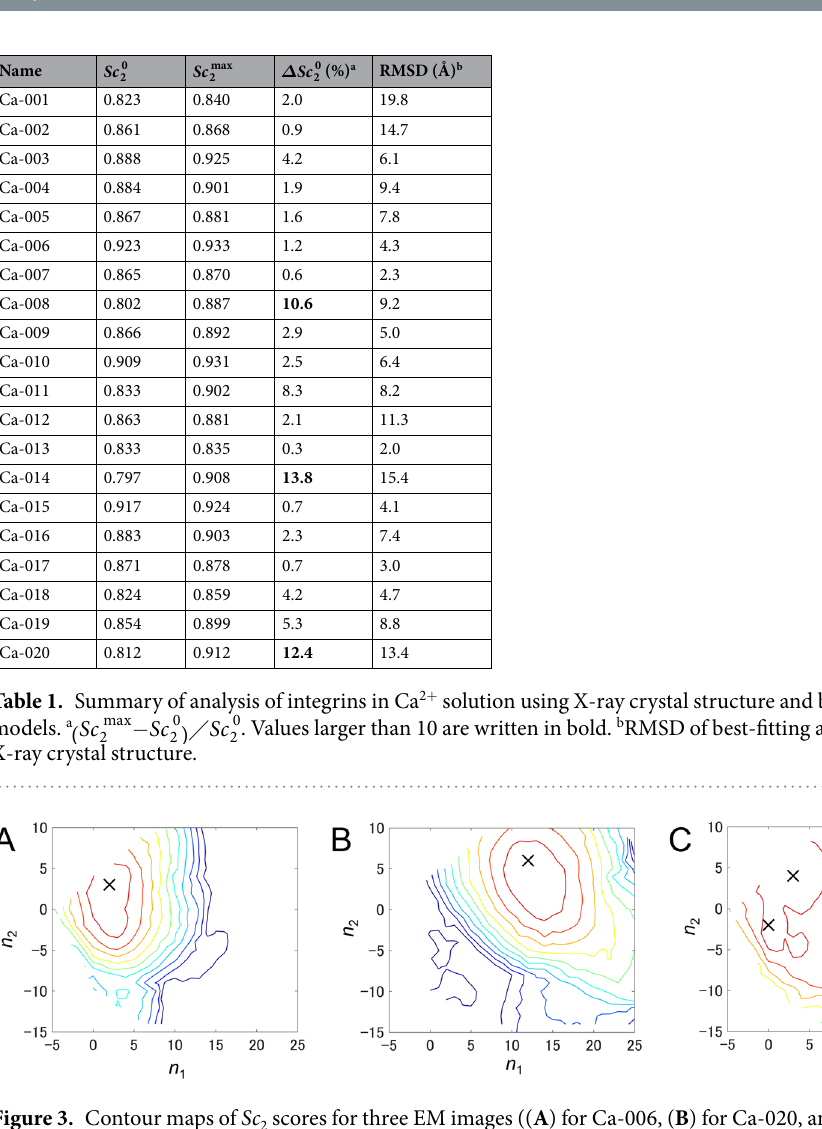
atomic models with different conformations in order to determine the best-fitting atomic model. Selection of best-fitting models for EM images of integrins in Ca 2 + solution. From the numerous deformed atomic models built by iterative normal mode analysis and small deformations (see Methods), the best-fitting atomic model was selected for each EM image of integrin in Ca 2 + solution. The covariance matrix adaptation evolution strategy (CMA-ES) was used for finding the model with the maximum Sc 2 score 8 . As shown in Table 1, the maximum scores ( Sc 2max ) were generally high, suggesting that the models reproduced the EM images well. As expected from the successful reproduction of the EM images from the X-ray crystal structure, many best-fitting models were not too different from the X-ray crystal structure, with the root-mean-square deviation (RMSD) being less than 10 Å. Corresponding to the small RMSD, the increments of the scores from 0 ) were not very large (the average increments were ~4%). However, there those of the X-ray crystal structure ( Sc 2 were cases in which the increments were more than 10% (written as bold numerals in Table 1). In such cases, the RMSDs were relatively large and the X-ray crystal structure was often fitted to the EM images in incorrect ways (Supplementary Fig. S1), indicating that the fitting was sensitive to the conformational changes in the atomic model. To examine how fitting was dependent on the conformation, we built negative stain models for a range of atomic models r 12 ( n 1 , n 2 ), which were built by deforming the X-ray crystal structure along the two lowest-frequency normal modes, and calculated the Sc 2 scores; these scores are shown in Fig. 3 using contour maps. 4 Scientific RepoRts | 7: 377 | DOI:10.1038/s41598-017-00337-y